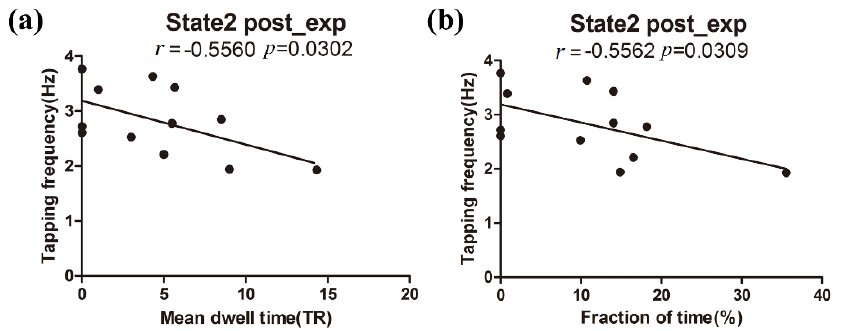
experimental group. ( a ) The significant regression relationship between the tapping frequency and the mean dwell time of state 2, and ( b ) the significant regression relationship between the tapping frequency and the fraction time of state 2.